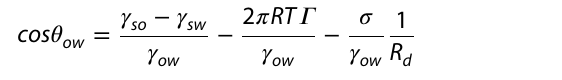
Fig. 6 a Left picture: Higher IFT at the droplet top generates Marangoni forces from the contact toward the top of the droplet. b Right picture: Surfactant absorption lowers the oil–silica crystal contact angle, inducing the spreading of the droplets over the silica surface